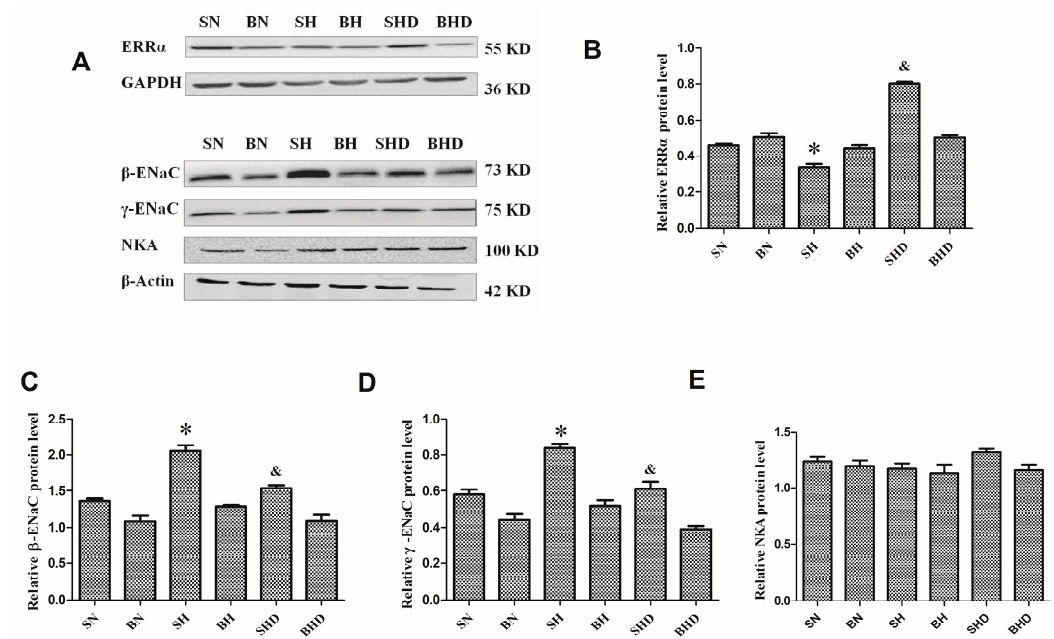
Figure 3. Expressions of ERR α , Na-K-ATPase, β -ENaC and γ -ENaC in rats. * p < 0.05, compared with BH, SN, and SHD groups. & p < 0.05, compared with BHD group. ( A ) protein expressions in all groups; ( B ) relative quantitative analysis of ERR α protein level; ( C ) relative quantitative analysis of Na-K-ATPase protein level; ( D ) relative quantitative analysis of β -ENaC protein level; ( E ) relative quantitative analysis of γ -ENaC protein